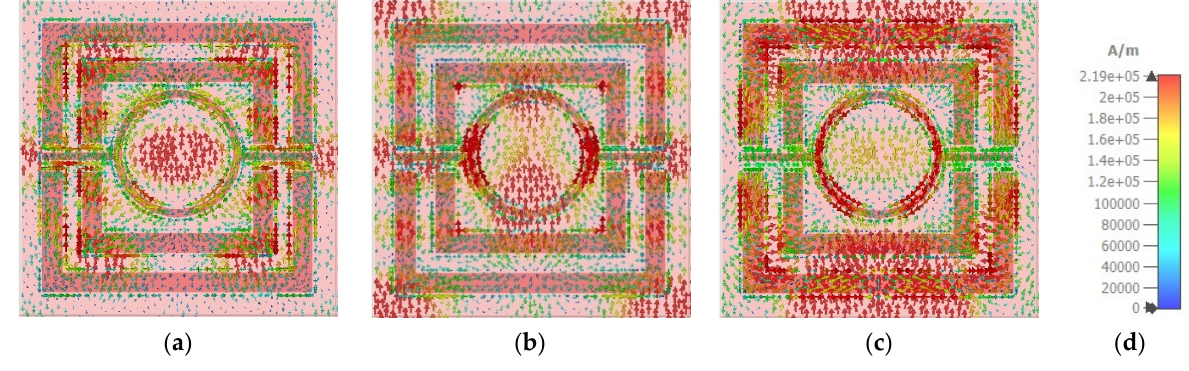
Figure 15. Surface current distribution at ( a ) 450 nm ( b ) 557 nm ( c ) 650 nm ( d ) A/m scale.